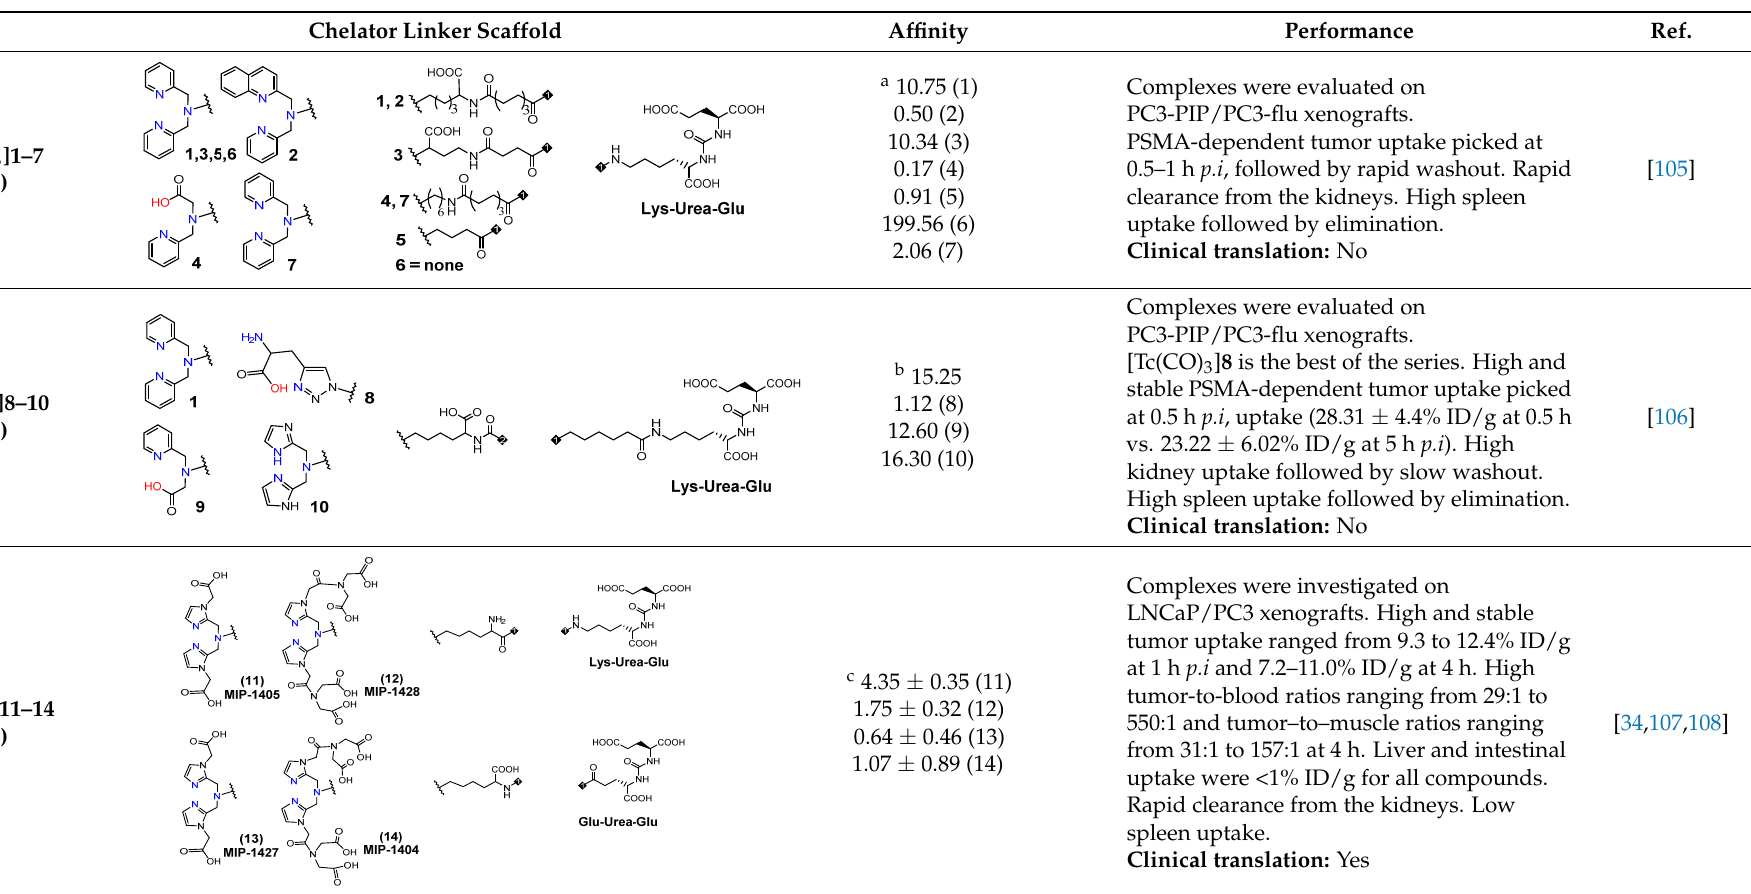
Low spleen uptake Clinical translation: